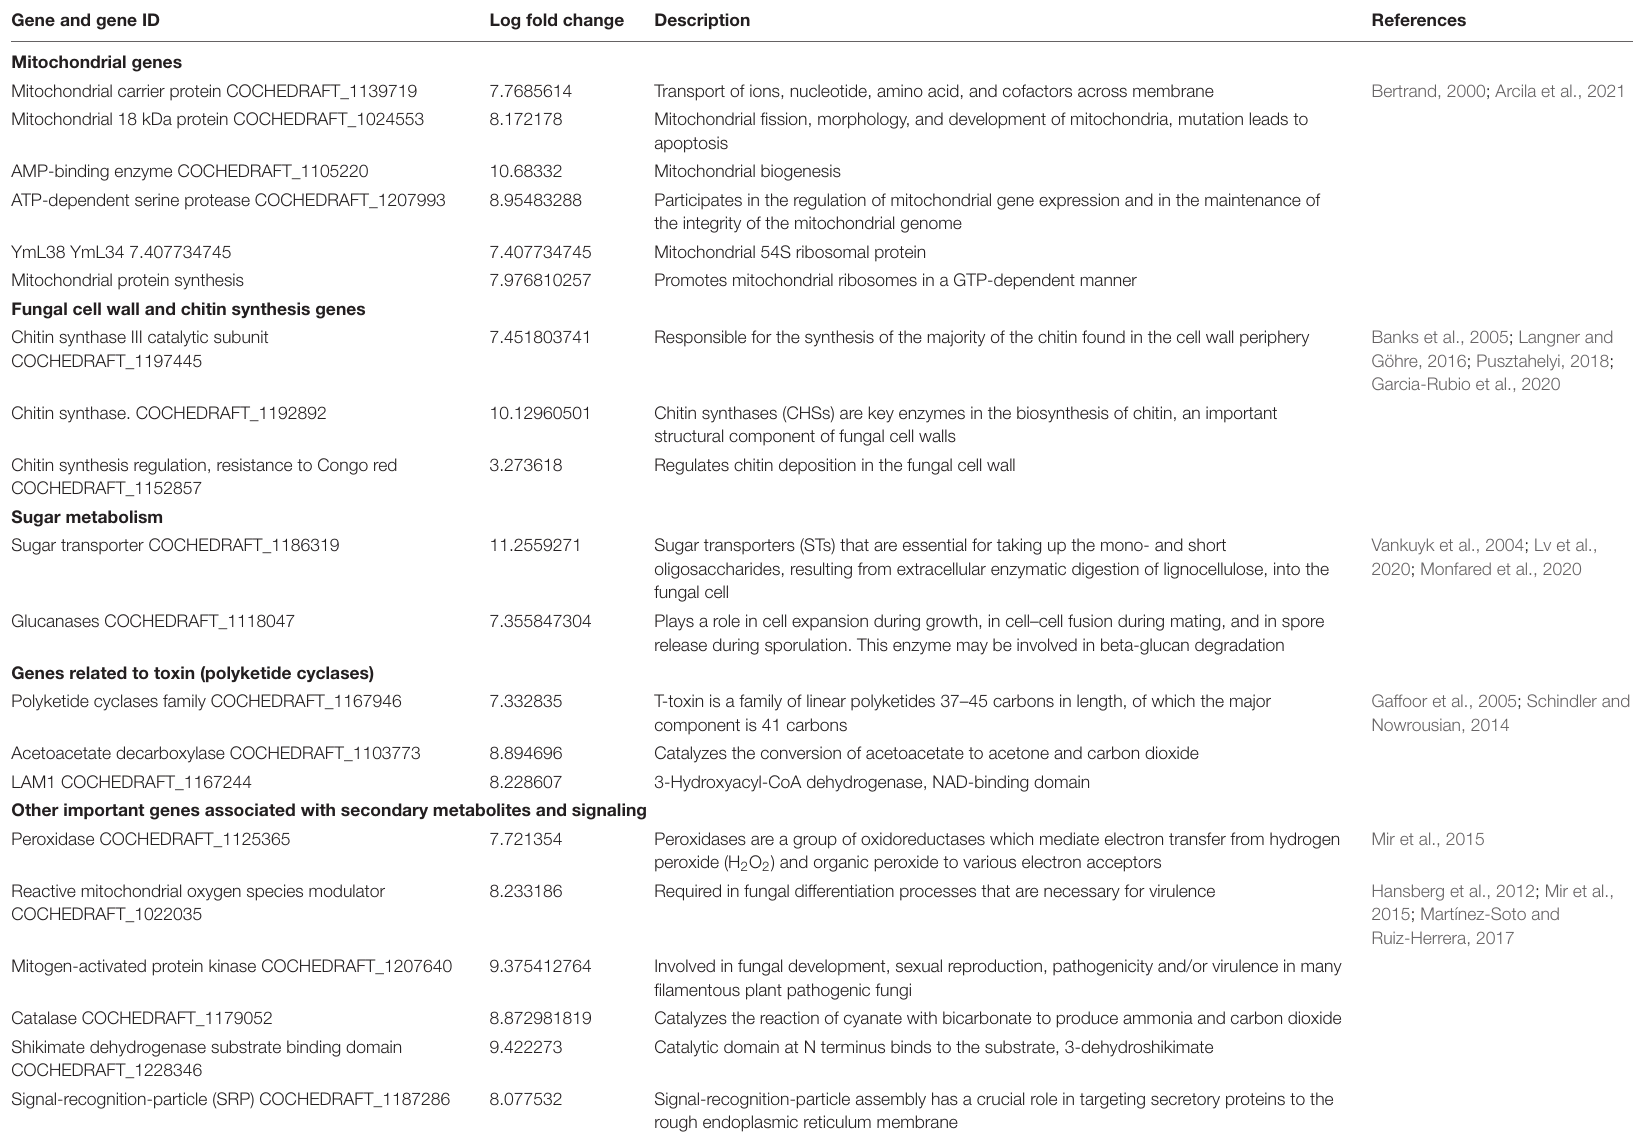
TABLE 4 | Important upregulated genes for pathogen fitness and